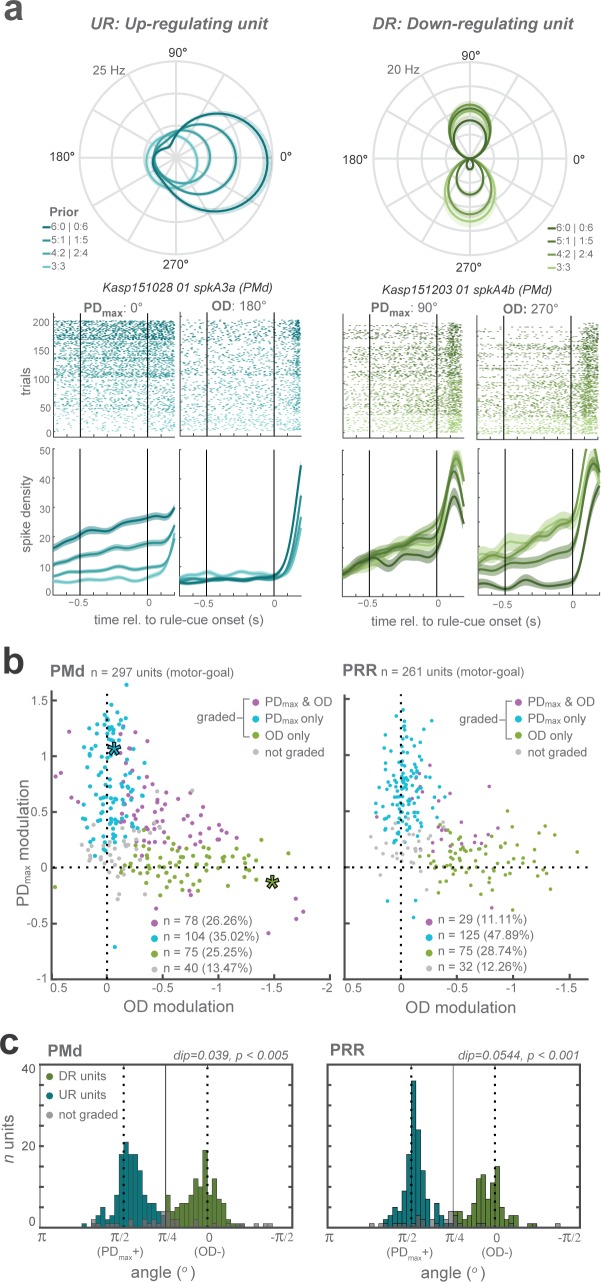
Distinct classes of prior-dependent graded modulation in single units.(a) Examples neurons with graded modulation at the neuron’s maximum direction (PDmax; left panel) or opposite direction (OD; right), respectively. Polar plot tuning functions (top) and raster plots with averaged spike densities (bottom) of each unit are shown for each prior level as different shades. (b) Graded modulation is quantified as function of prior separately in the PDmax and the OD, and plotted against each other, for all PMd (left) and PRR (right) neurons. The upper-right quadrant reflects increasing activities (positive modulation) of PDmax responses and decreasing activities (negative modulation; inversed x-axis) of OD responses. Purple data points: neurons that showed significant modulation of both PDmax and OD activities as function of prior; blue: prior-dependent modulation of PDmax responses only; green: modulation of OD responses only; gray: no modulation. Asterisks indicate the example units shown in (a) (blue - left unit (PDmax-graded); green - right unit (OD-graded)). (c) The angular distribution of relative PD and OD modulation in all graded neurons in each area, with results of Hartigans’ dip test, indicating bimodality with a concentration of the modulation along the PDmax(+) and OD(-) axes. Two shades of colors signify our henceforth two categories of neurons, up-regulating (UR) and down-regulating (DR) neurons.10.7554/eLife.47581.007Figure 3—source data 1.Prior-modulation at PDmax and OD, along with relative modulation strength for each PMd and PRR units.